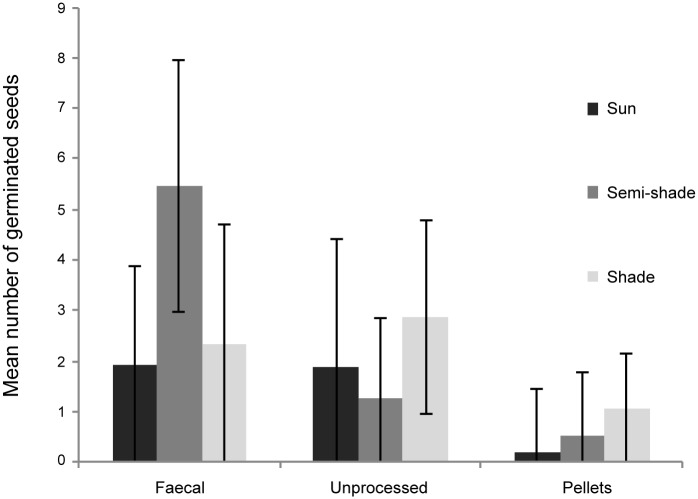
Germination success of fig seeds in semi-natural conditions.Mean germination success of Ficus polita faecal, unprocessed and from rejecta pellet seeds under three different light intensities. Each treatment was replicated 15 times with 20 seeds/replicate (2,700 seeds tested). The bars represent standard deviations.